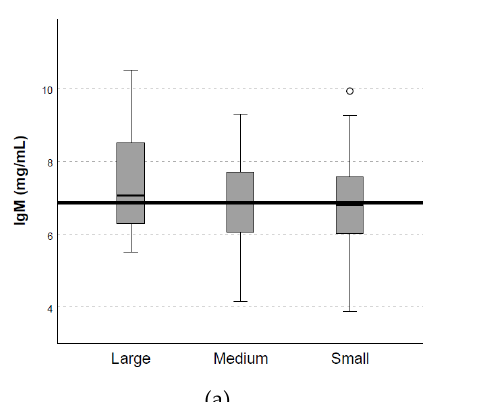
0.705 Figure 4. Effect of body weight at first service on serum immunoglobulin concentrations: (a) IgM, (b) IgG, (c) IgA, (d) insulin, (e) cortisol, and (f) IGF-1. Weight group at first service: (1) Large sow (>150 kg BW; n = 16); (2) Medium sow (135–150 kg BW; n = 32); (3) Small sow (<135 kg BW; n = 32). Solid horizontal line represents global median for each blood metabolite. No significant differences were detected between weight groups of gilts ( p > 0.05). °,*: outliers are identified with different